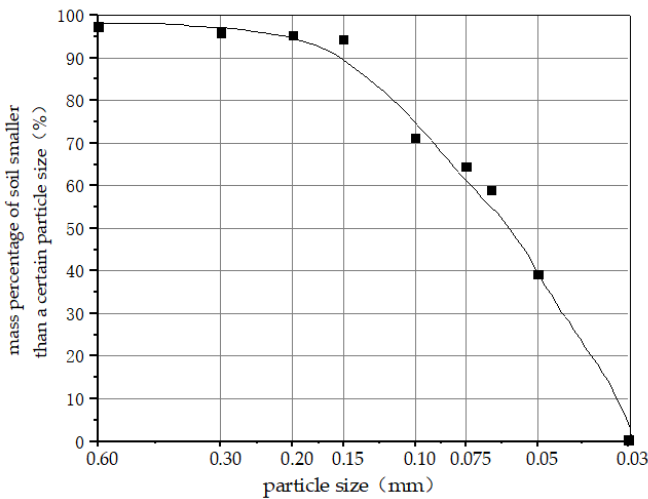
Figure 2. Particle gradation